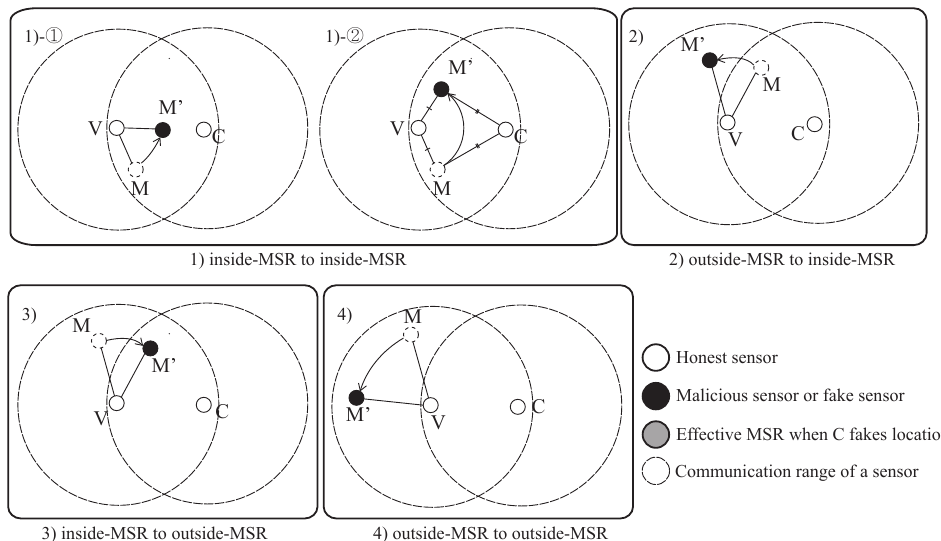
Figure 9. The effect of a malicious neighbor on D-filtering between honest sensors.